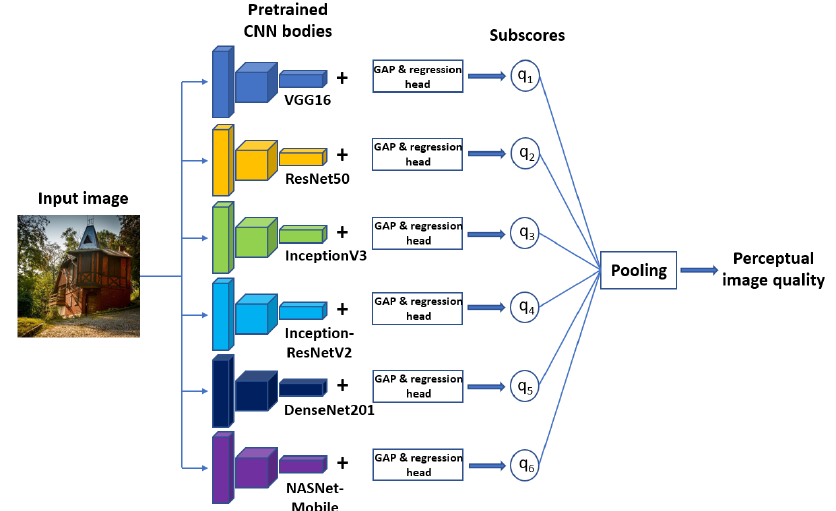
Figure 4. High-level overview of the proposed method. An input image is passed through six in-parallel CNN bodies followed by global average pooling layers and regression heads. The six branches are trained using the same train and validation datasets but independently from each other. To obtain an overall quality score for the input image, the quality predictions of the six branches are